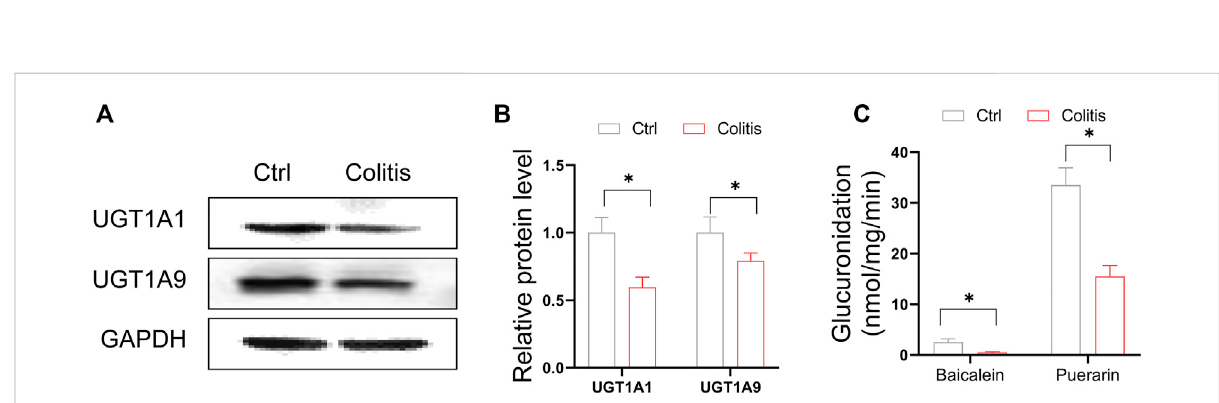
FIGURE 3 Downregulation of hepatic UGT1A1 and UGT1A9 in colitis leads to dampened glucuronidation. (A) Protein expression levels of UGT1A9 and UGT1A1 in the liver of colitis and control mice. (B) Quantitative data of Western blotting in (A) . (C) Liver microsomal metabolism assay showing glucuronidation rate of baicalein and puerarin in colitis and control mice. * p <